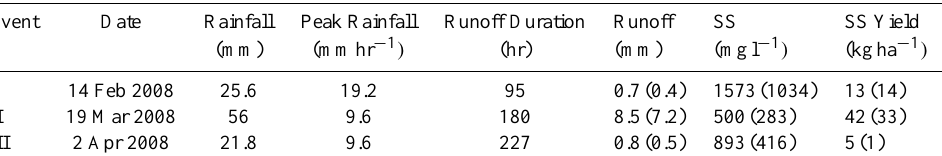
Table 1. Characteristics of events monitored during rare earth oxide tracer experiment. Data are averages for all four collection tanks sampled, with standard deviations shown in parentheses.